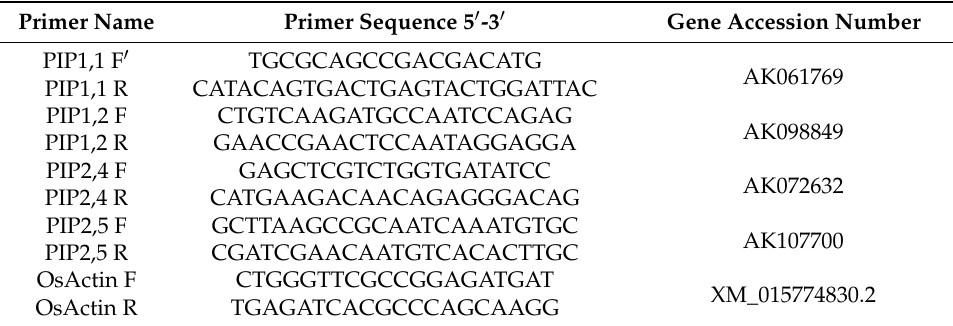
Table 2. The primers used for real-time PCR